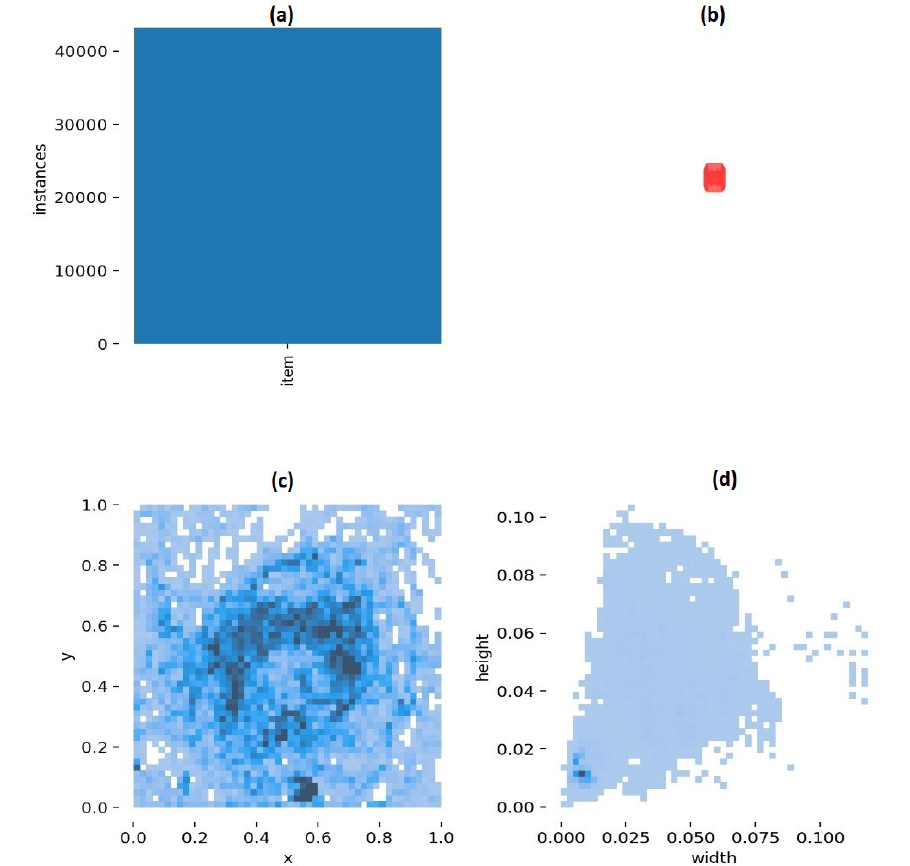
Figure 19. Model trained on SEAGULL—( a ) number of training items in the dataset, ( b ) anchor boxes used for the final bounding boxes, i.e., the detections, ( c ) frequency of the central positions of the objects of the dataset, ( d ) size of the bounding boxes as a percentage of the images’ width and height for the SEAGULL- and SEAGULL+COCO-trained models,